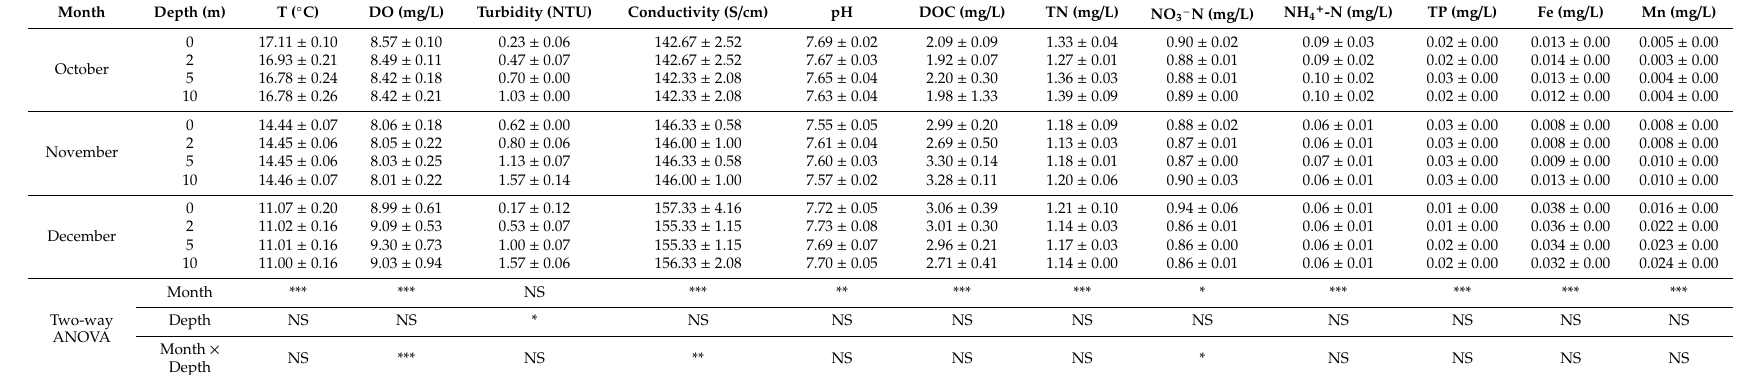
Table 1. Water quality parameters of Jinpen reservoir measured from October to December in